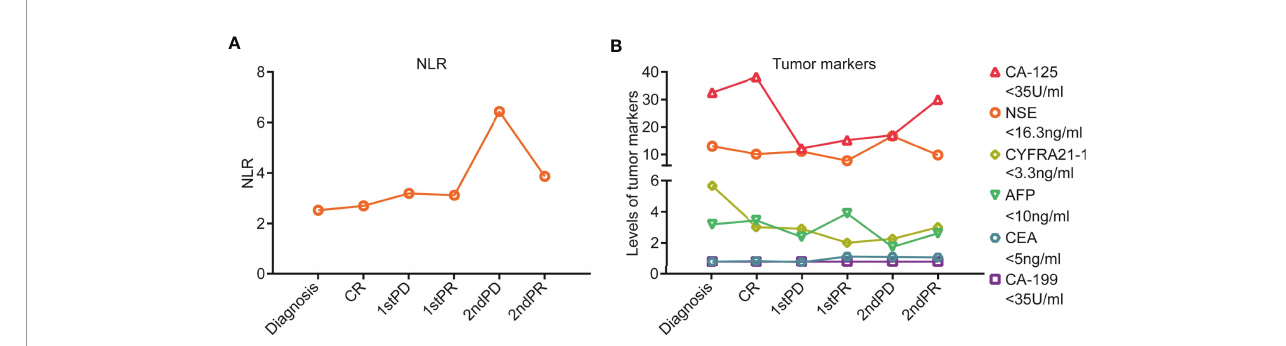
FIGURE 3 | Blood test results during the treatment process for the patient. (A) NLR value and its dynamic changes during the treatment process. (B) Tumor marker levels and their dynamic changes during the treatment process, including CEA, AFP, CA199, CA125, NSE,